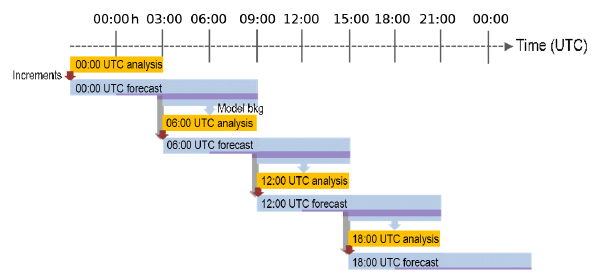
Figure 2. Cycling set-up of BARRA-R at base time t 0 = 00:00, 06:00, 12:00, and 18:00UTC. Each UM forecast is initialized at t 0 − 3h by the previous forecast (grey arrows) with increments from the current analysis (red arrows). The purple bars indicate the time steps of the model states that have been